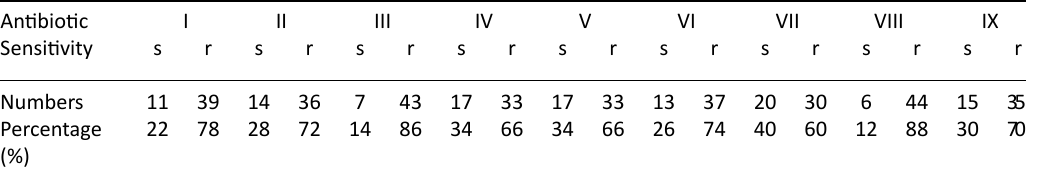
Table 1. Antibiotic sensitivity of isolates with highly diversified plasmid DNA (50 samples)